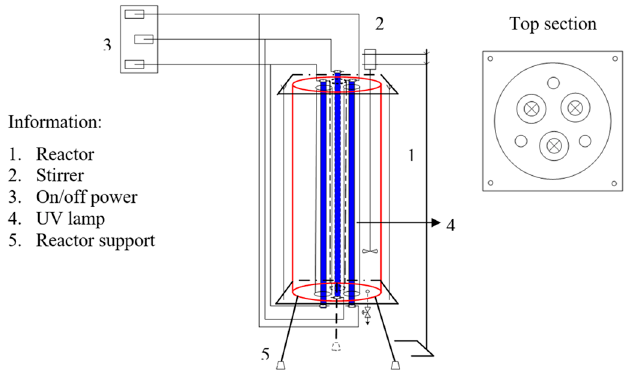
Figure 8. Scheme of reactor to perform textile wastewater degradation by peroxide oxidation assisted by UV light irradiation. Reactor dimensions: 32 cm length, 9 cm diameter, and 1.2 L capacity. Intensity of UV light: 35 watt/m 2 .